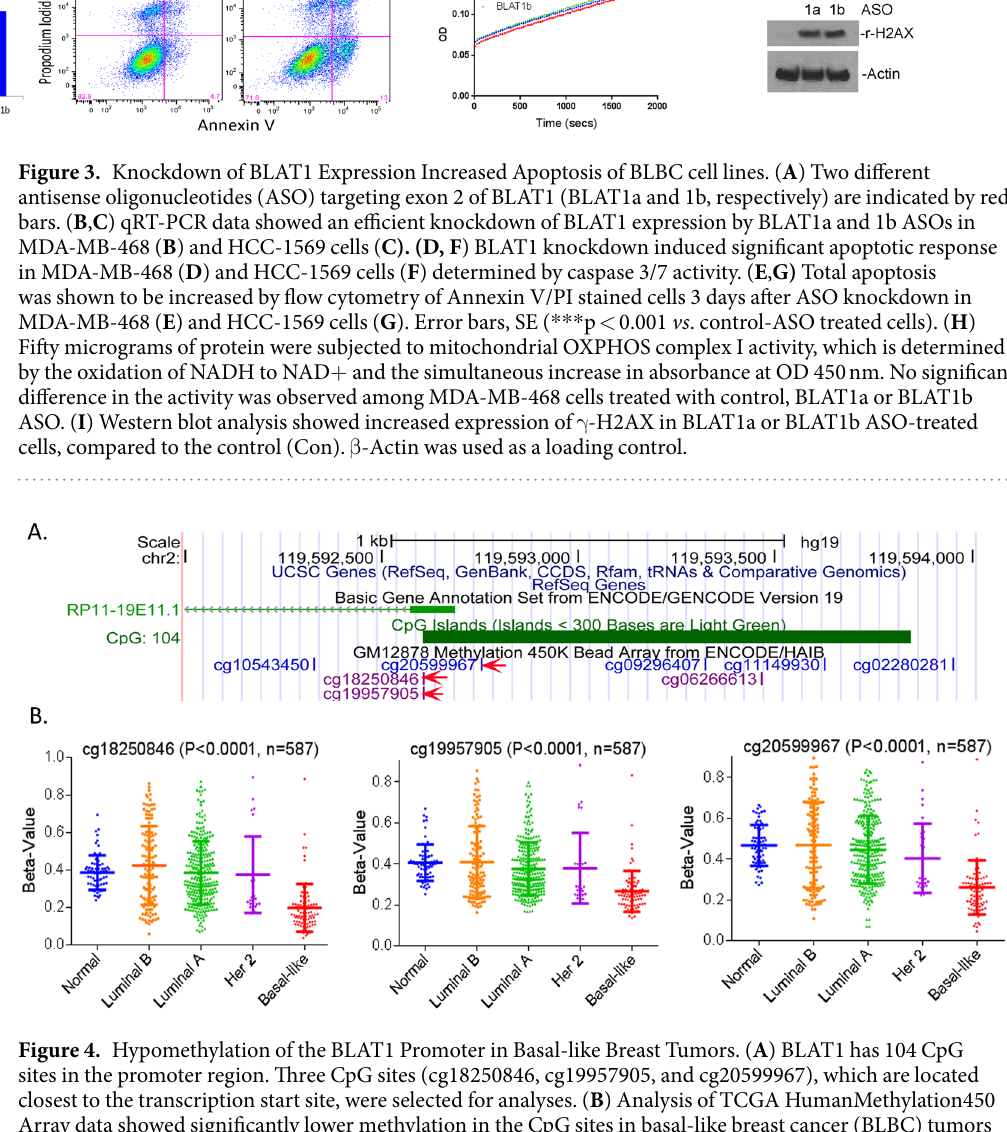
tumors compared to all other tumors (Fig. 5E). Additionally, the basal-like cell line HCC-1569 showed the highest expression of EN1 among all cancer cells (Supplementary Fig. 1B). Correlation between BLAT1 and EN1 methylation. Because both BLAT1 and EN1 are hypometh- ylated and highly expressed in BLBC tumors, we investigated the relationship between the two genes using TCGA methylation and RNA-seq datasets (Supplementary Fig. 1C,D). We found that methylation of the BLAT1 CpG site, cg18250846, is significantly correlated with the methylation status at three sites in the EN1 promoter (cg20248516, cg22030072, and cg17167253) in breast cancer (p < 0.0001) (Supplementary Fig. 1C). Similarly,